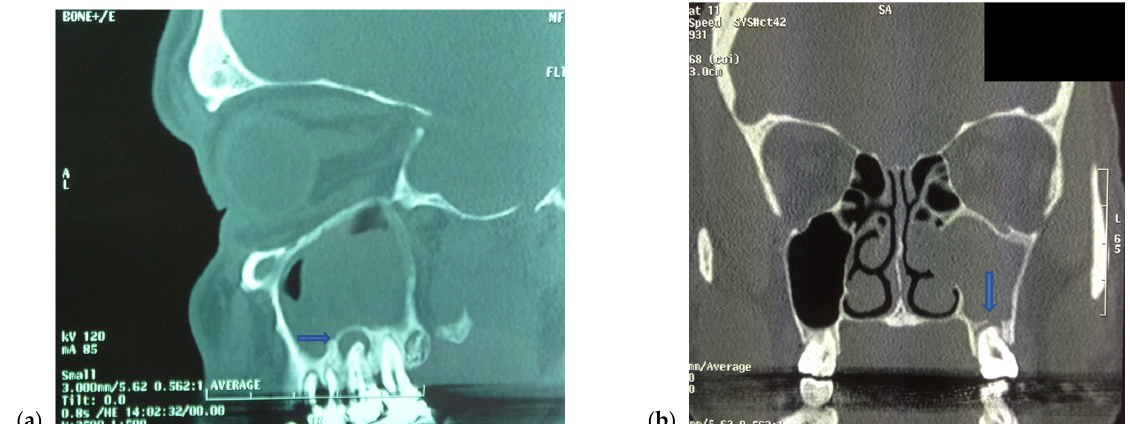
Figure 2. Computed tomography demonstrating maxillary sinusitis secondary to ( a ) periapical abscess on sagittal view (horizontal arrow) and; ( b ) periodontic disease on coronal view (vertical arrow).